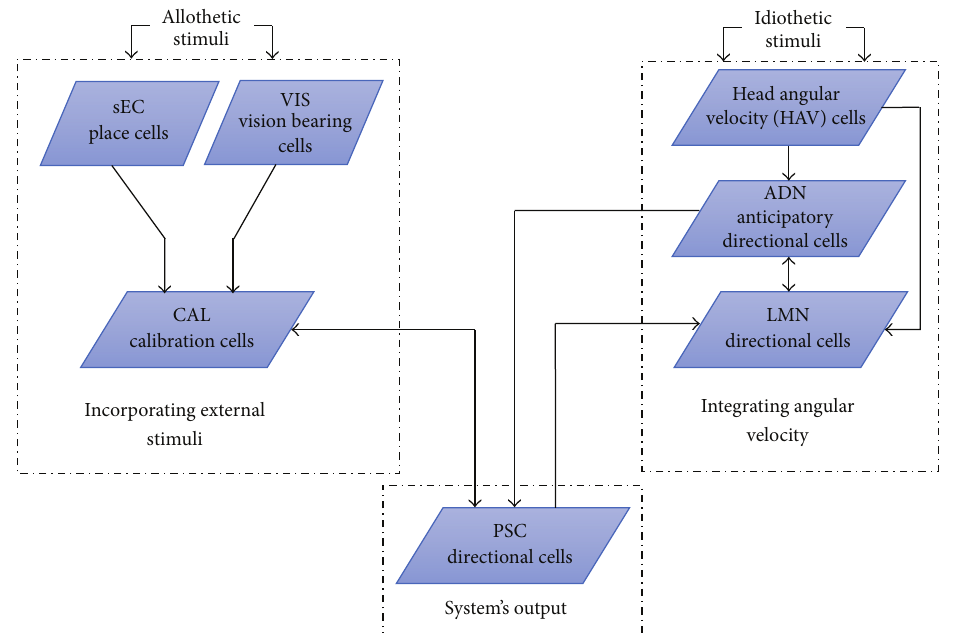
Figure 2: A functional overview of the directional system